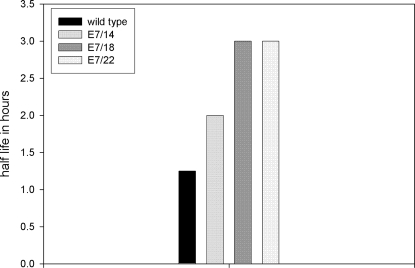
An Actinomycin D time course demonstrated that message stability increased with increasing numbers of codon changes.RNA was isolated from transiently transfected cells at different time points from 0 to six hours post treatment. RNA stability increased with increasing numbers of codon changes.